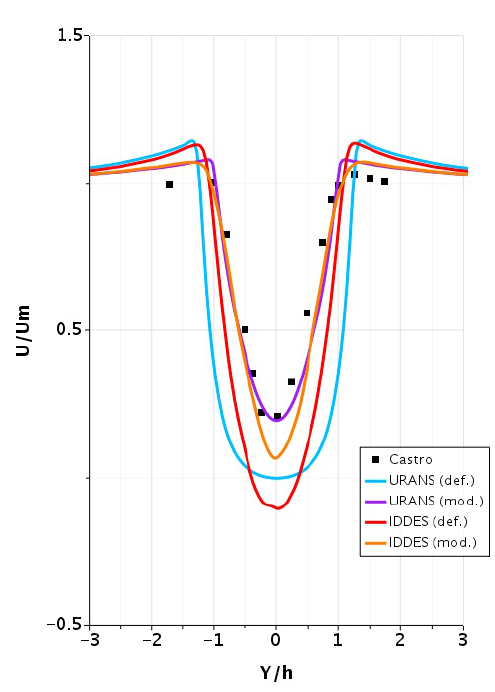
Figure 7. Comparison of Spanwise Mean Velocity along the Symmetry Plane at x / h = 2.0 and z / h =